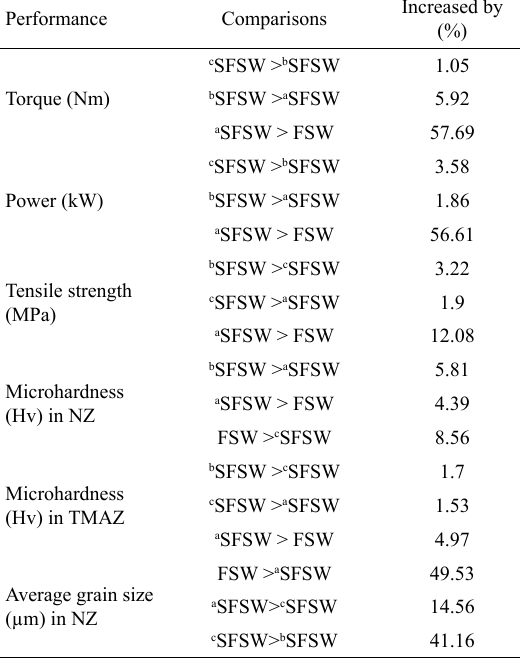
Table 3. Comparisons of performance between FSW and SFSW Performance Comparisons